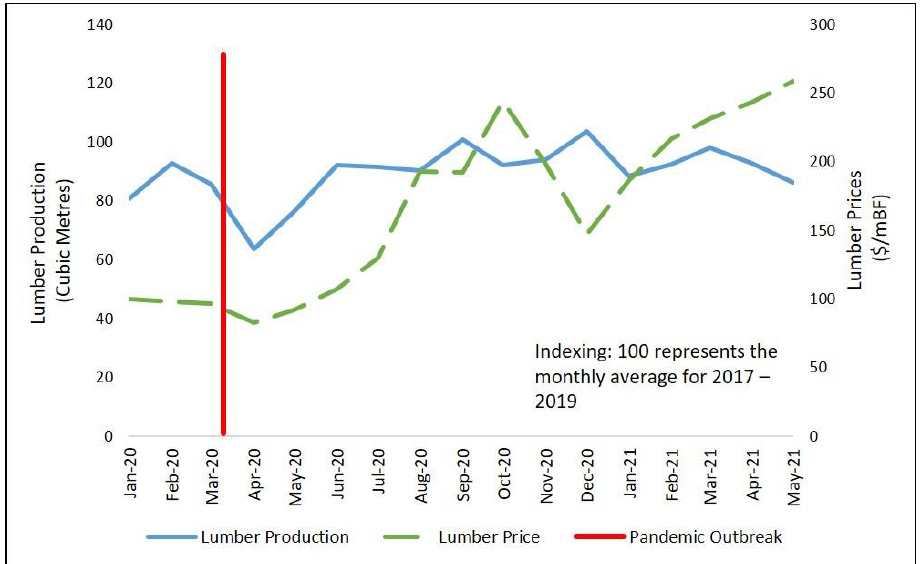
Figure 3. Monthly lumber production and lumber